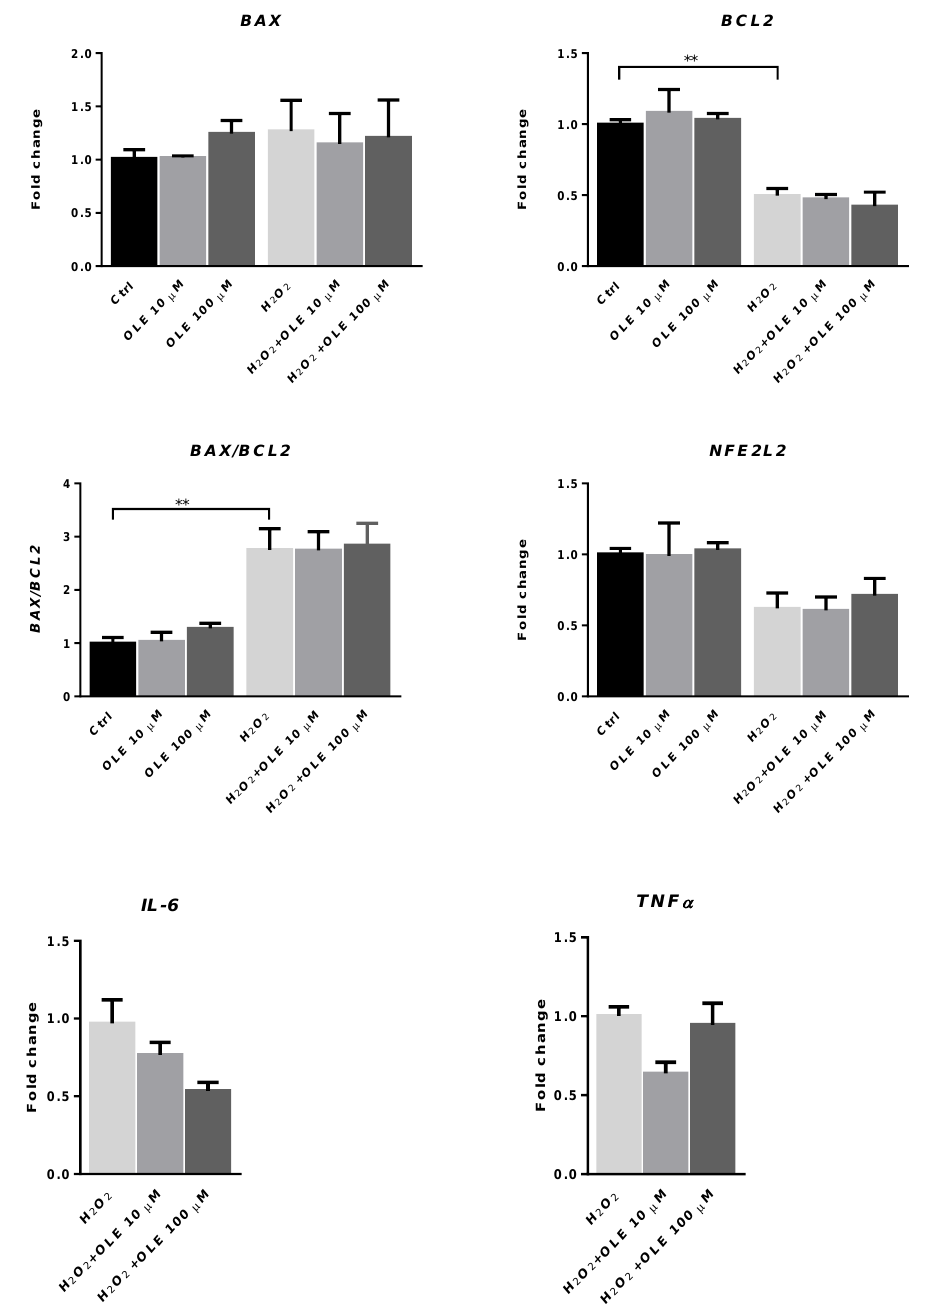
Figure 7. The effect of oleuropein (OLE) on the mRNA expression of apoptotic marker BAX , the anti-apoptotic marker BCL2 , the mRNA ratio of BAX to BCL2 and the mRNA expression of redox- regulated transcription factor NFE2L2 , interleukin 6 ( IL6 ) and tumor necrosis factor α ( TNF α ), in H 2 O 2 -exposed HTR-8/SVneo cells. The data are expressed as mean + SEM. ** p < 0.01.